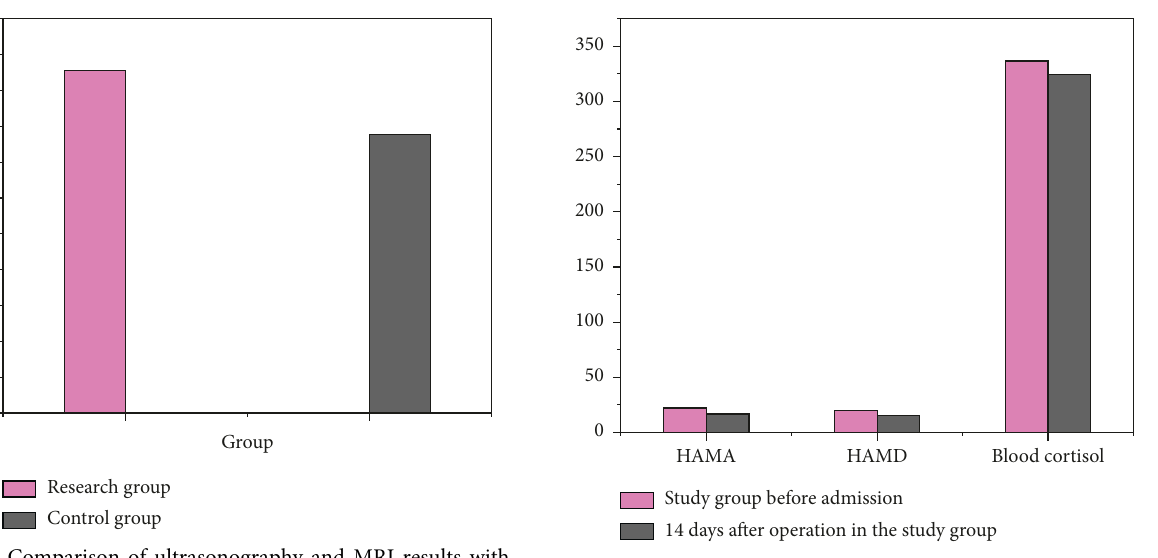
Figure 4: Comparison of perioperative mood changes of patients in the study group (MeanSD).